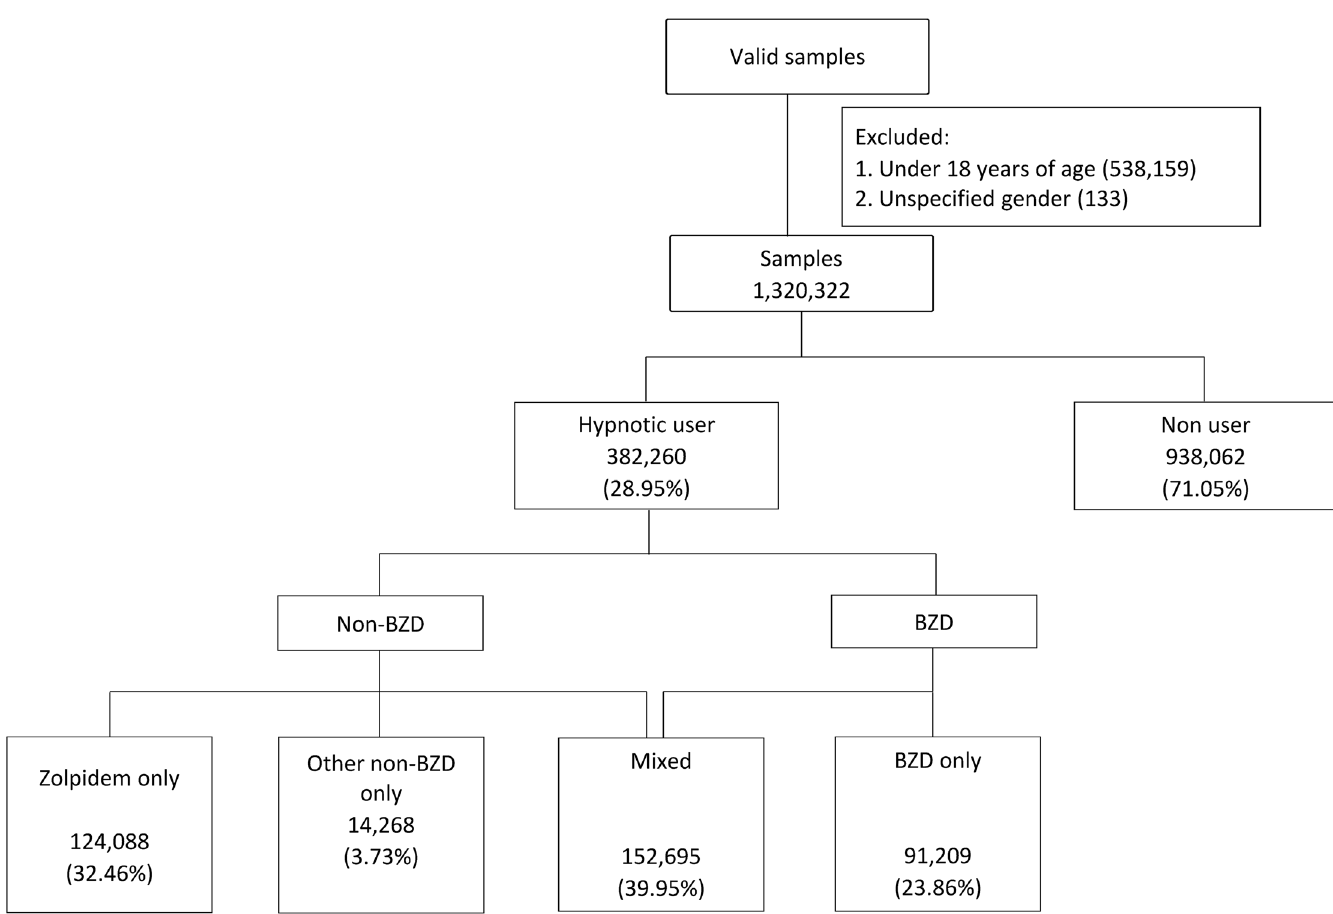
Fig 2. Flowchart of sample selection and classification. ( “ Mixed ” refers to the use of a combination of zolpidem and other non-BZDs or non-BZDs and